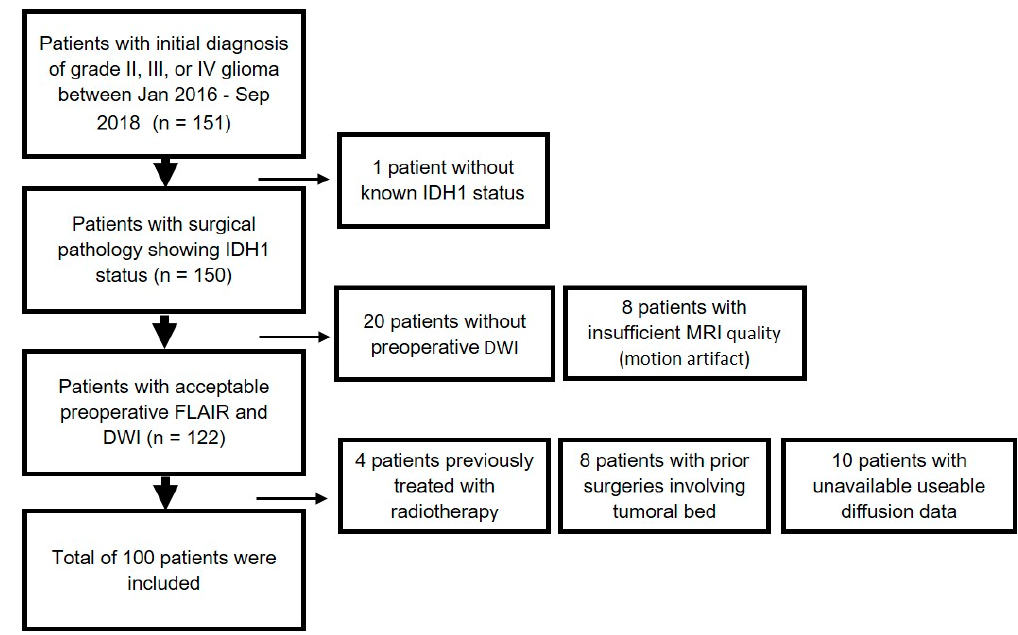
Figure 3. Flowchart of Patient Inclusion and Exclusion.